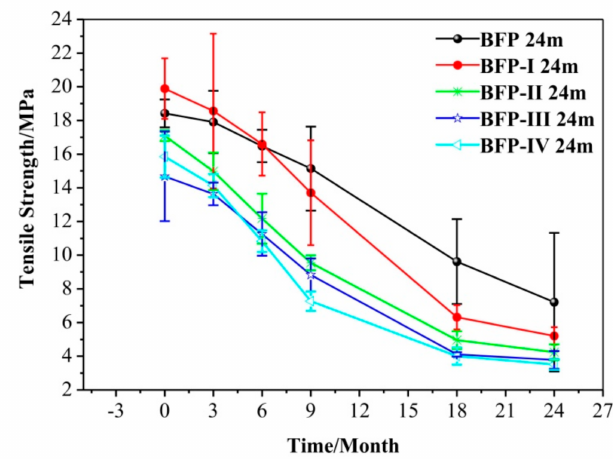
Figure 3. Effect of HSPI content on the tensile property of the BFP-I, BFP-II, BFP-III, and BFP-IV and BFP